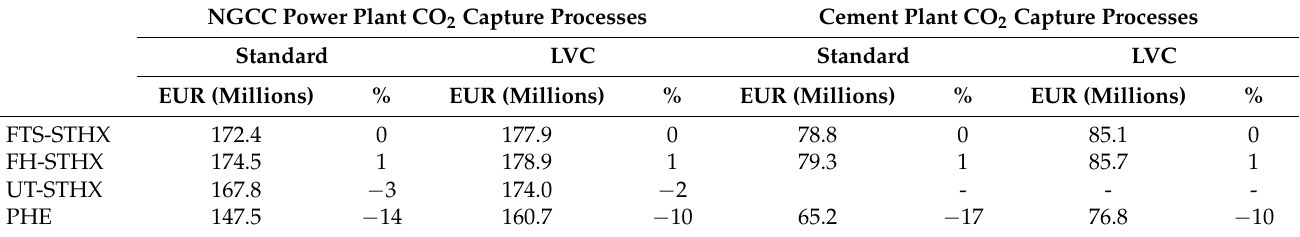
Table 7. Comparison of the base cases’ total plant costs (TPCs) of the different plant scenarios (reference: